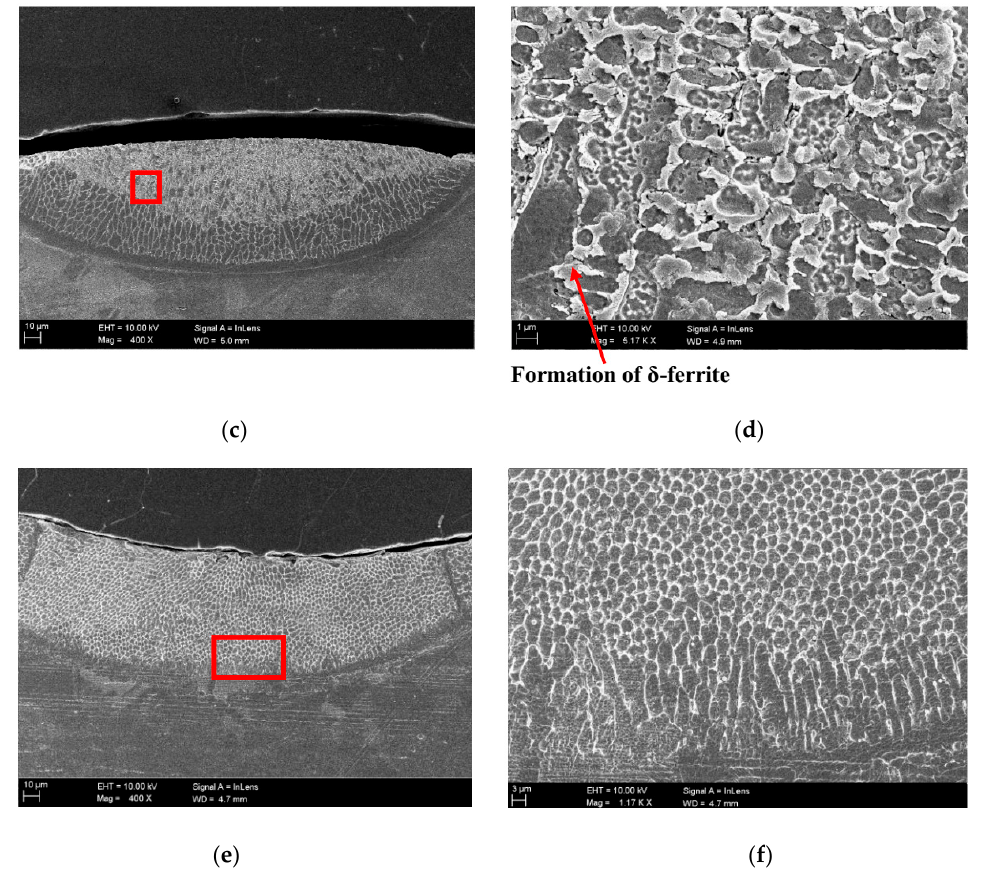
Figure 9. SEM images of the samples obtained at ( a , b ) D b = 0.25, h s = 1.0; ( c , d ) D b = 0.5, h s = 0.5; and ( e , f ) D b = 1.0, h s = 0.5 mm.